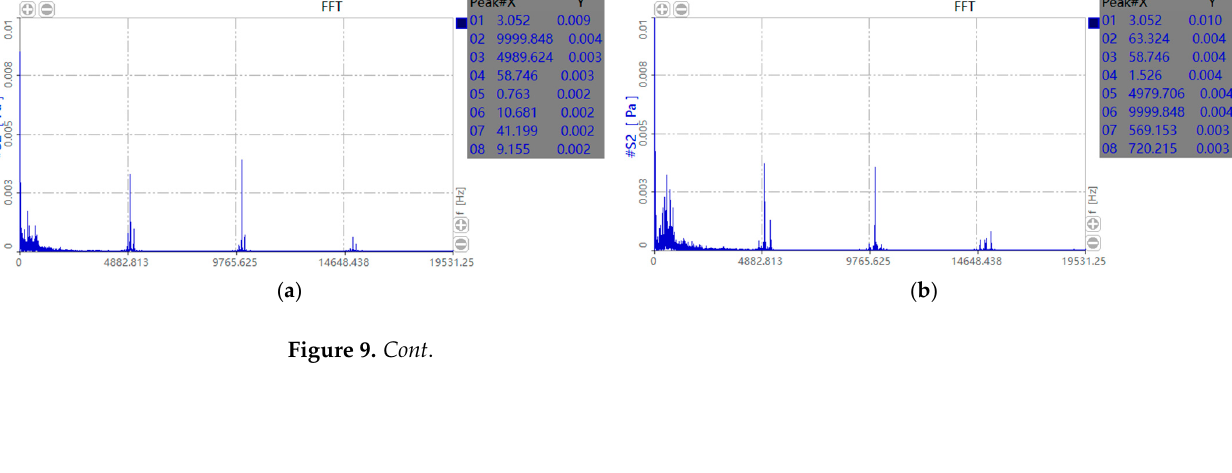
Figure 8. Vibration acceleration of three measuring points on the frame.